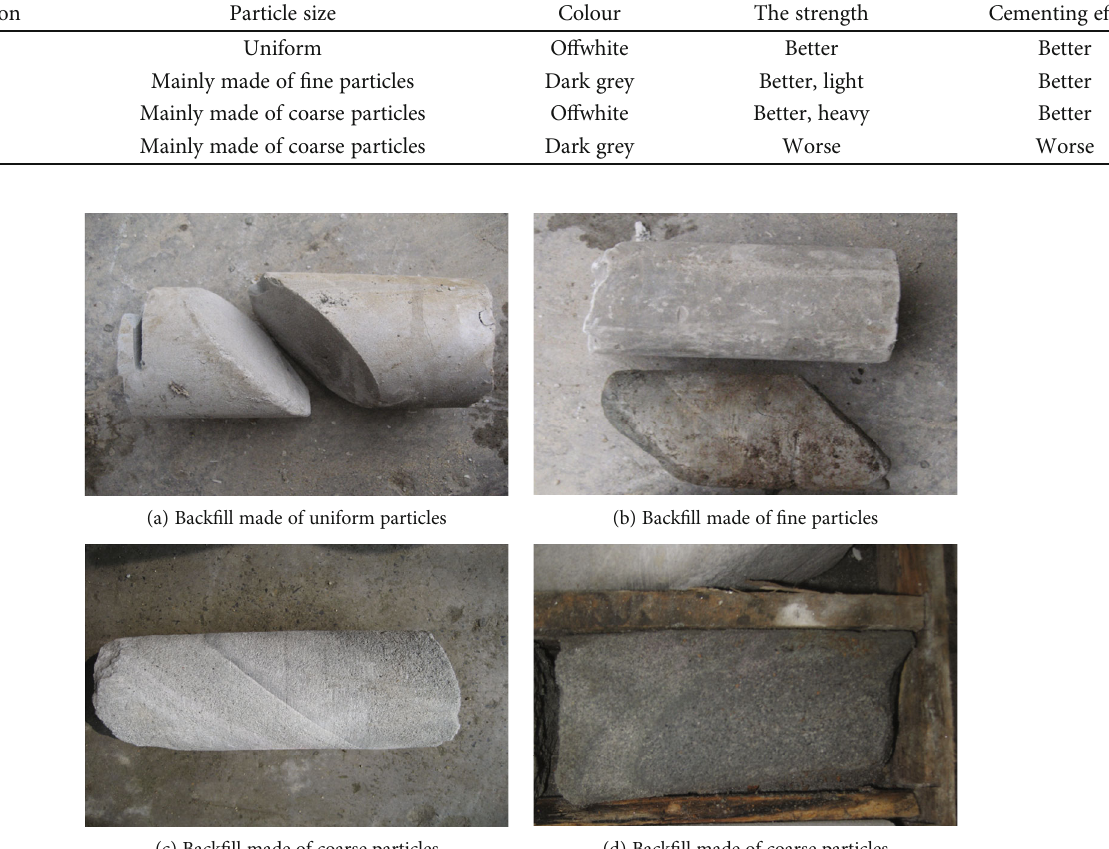
Figure 6: Back fi ll made of di ff erent particles.